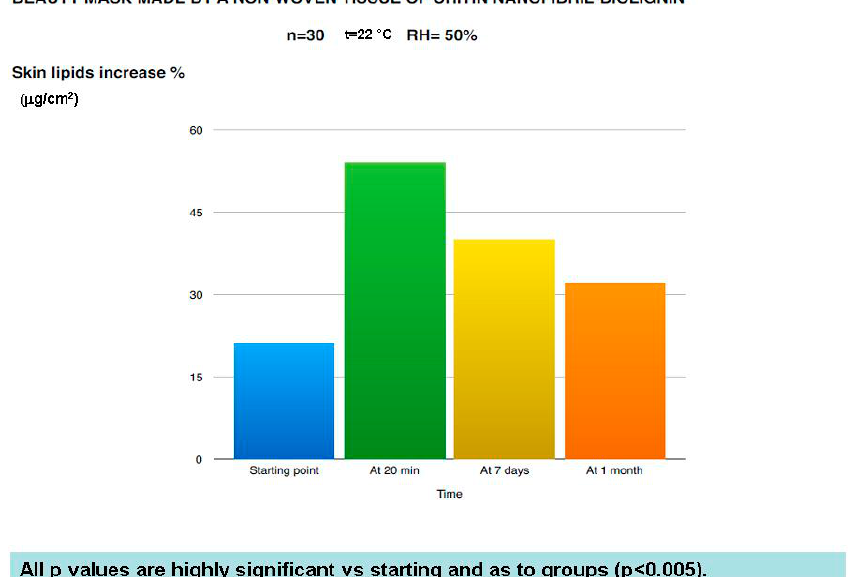
Figure 9. Effectiveness of the mask on the skin lipids balance of photoaged women.